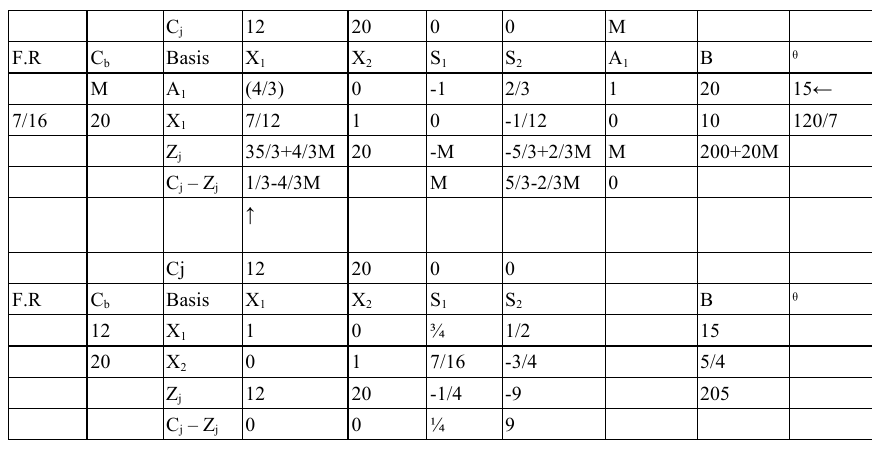
Table 3. 2 ND AND 3 RD